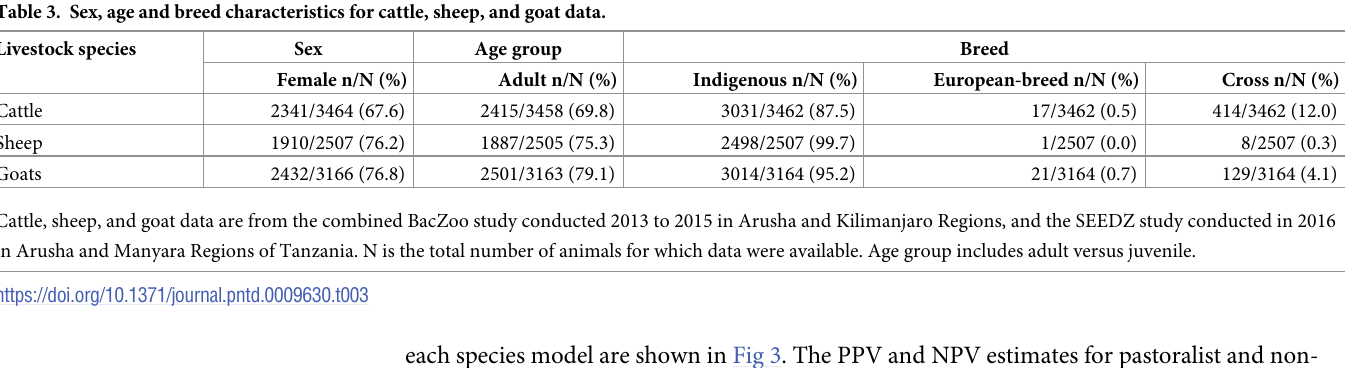
each species model are shown in Fig 3. The PPV and NPV estimates for pastoralist and non- pastoralist subpopulations of cattle, sheep, and goats are given in Table 5.